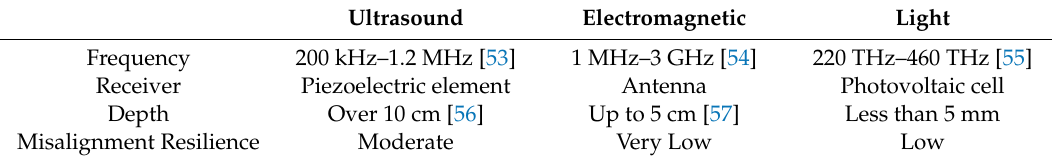
Table 2. Typical metrics of ultrasound, electromagnetic, and light remote power (or wireless power transfer)